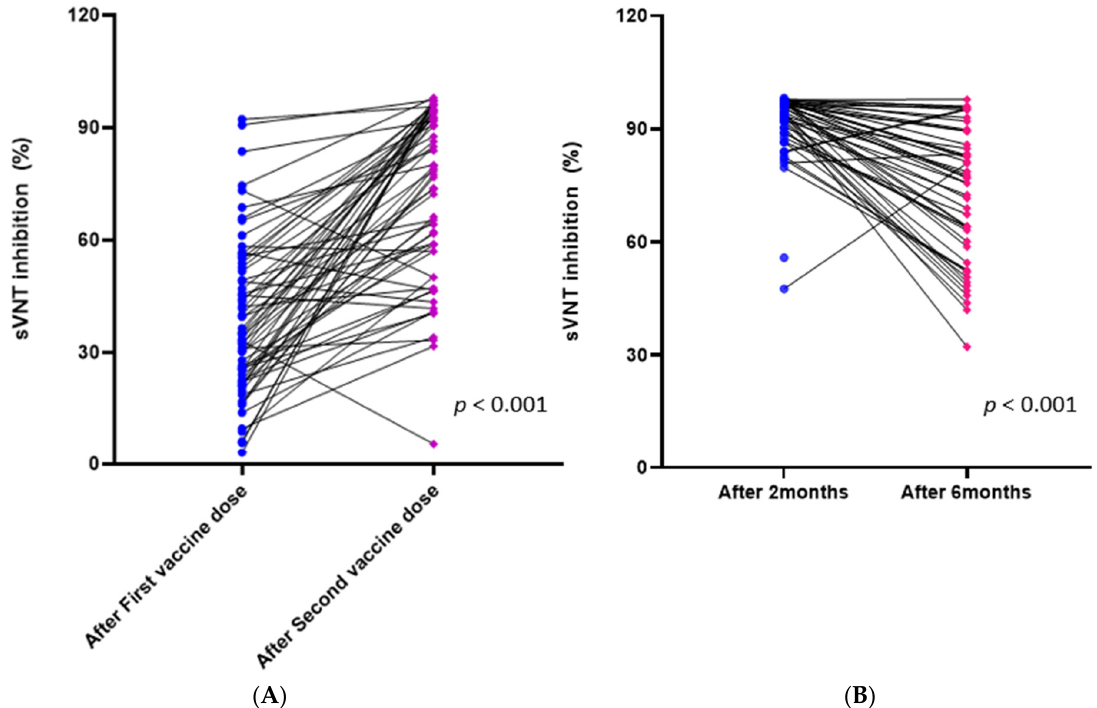
Figure 2. ( A ) Changes in sVNT inhibition (%) scores after the first and second doses in the ChAdOx1 group, ( B ) changes in sVNT inhibition (%) scores at two months and six months after the second dose in the BNT162b2 group. The sVNT inhibition scores negatively correlated with age among all the populations, regardless of the type of vaccine (correlation coefficient, of − 0.22, p < 0.044). The type of vaccine remained independently associated with higher sVNT inhibition scores in a mul- tiple linear regression ( p < 0.001) (Supplementary Table S1).